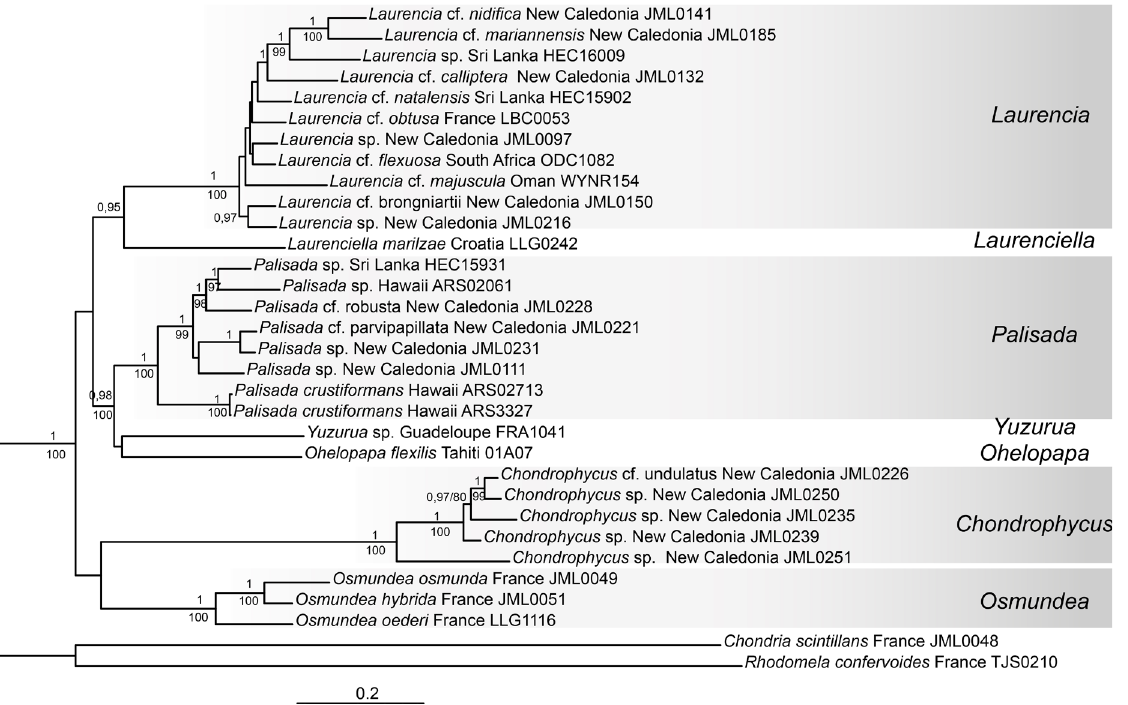
Fig. 2. Tree inferred from COI-5P + rbc L + LSU using Bayesian analysis (BI) and including 30 specimens of the Laurencia complex and two outgroup taxa. The numbers above branches indicate Bayesian posterior probabilities (pp) and below branches indicate bootstrap values (bp) inferred from 1 000 ML bootstrap replicates (ML); pp < 0.95 and bp < 75% are not